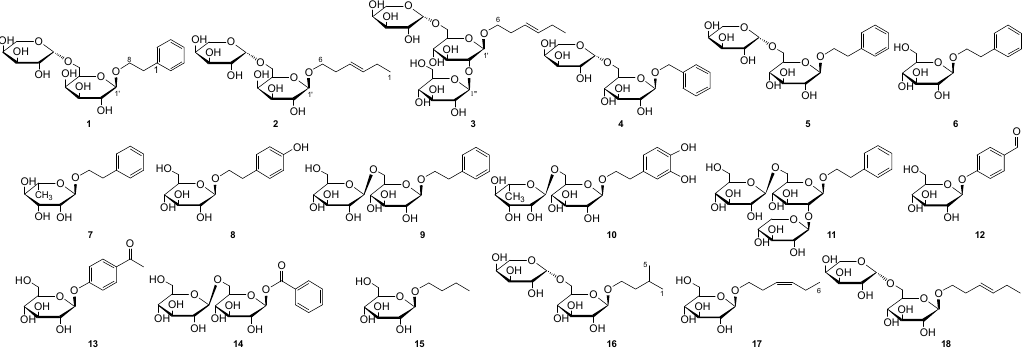
Figure 1. Structures of compounds 1 – 18 from Nicandra physaloides.